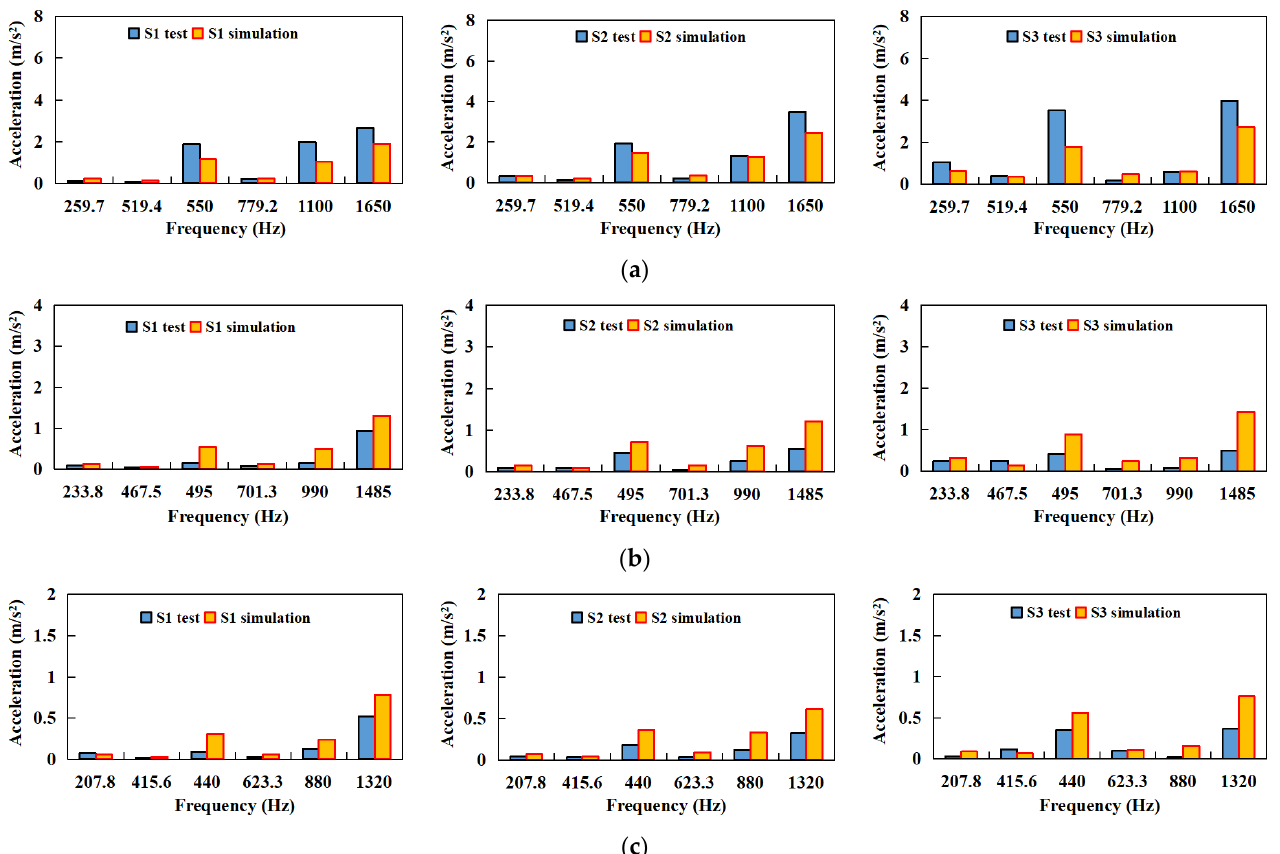
Figure 13. Comparison between simulation results and test data of housing vibration: ( a ) 3000 rpm 60 Nm input shaft, intermediate shaft, and output shaft accelerations; ( b ) 2700 rpm 60 Nm input shaft, intermediate shaft, and output shaft accelerations; ( c ) 2400 rpm 60 Nm input shaft, intermediate shaft, and output shaft accelerations.